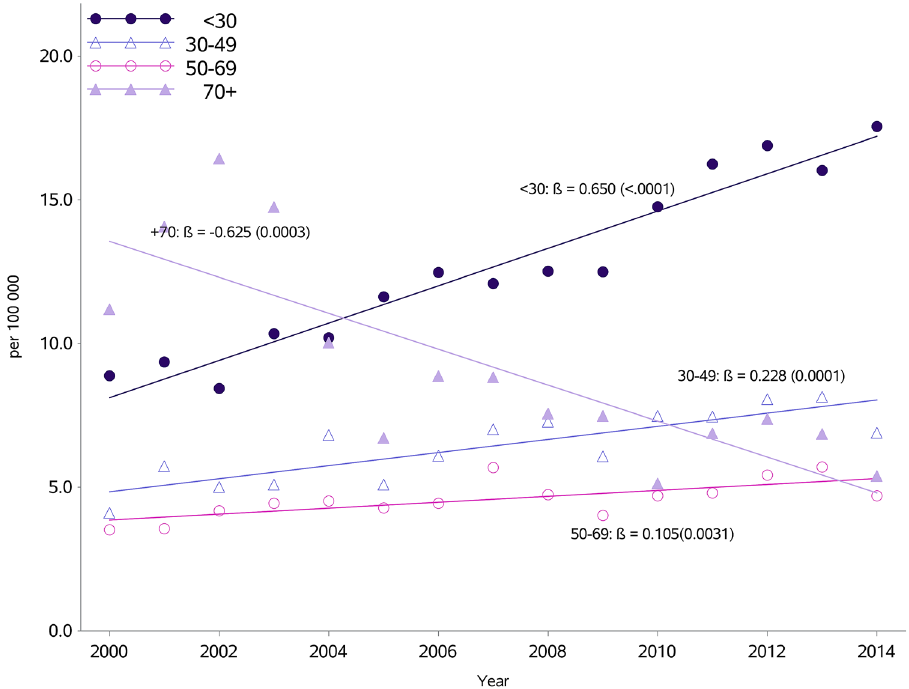
Figure 2. Incidence of myocarditis per 100,000 inhabitants in Sweden from 2000 to 2014 by